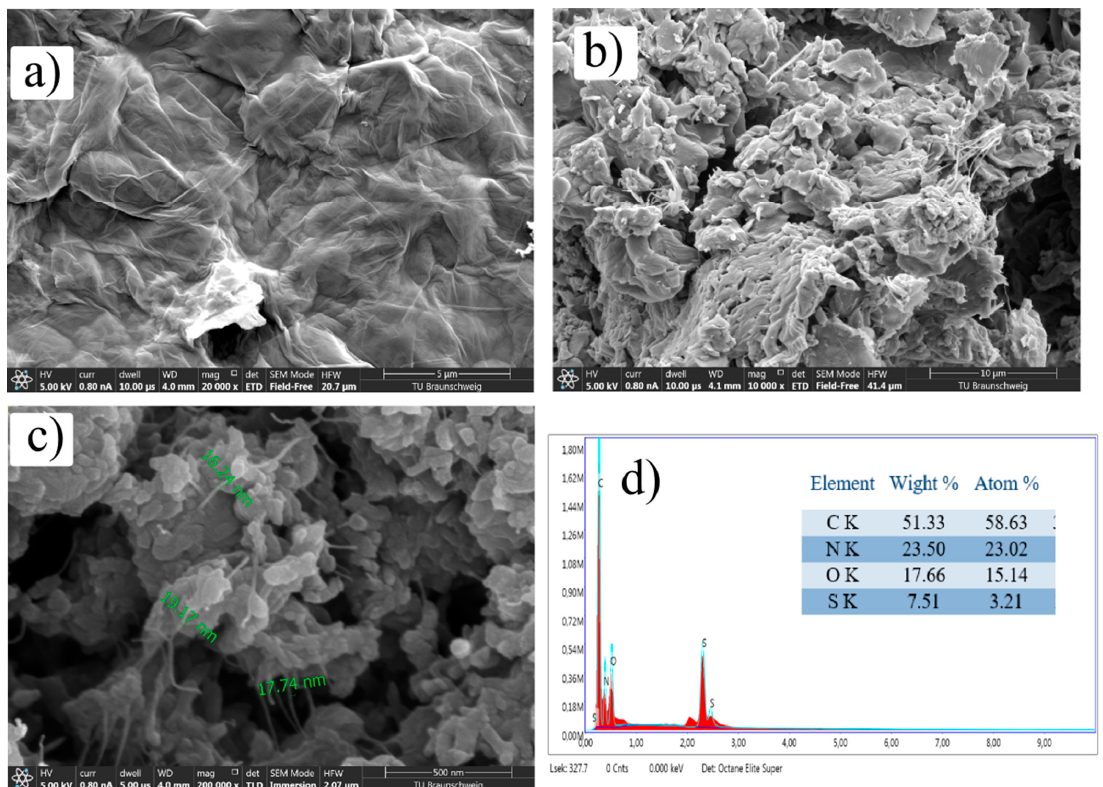
Figure 3. SEM images of ( a ) GO, ( b ) PANI, ( c ) GO@PANI nanocomposite and ( d ) EDX of GO@PANI nanocomposite.